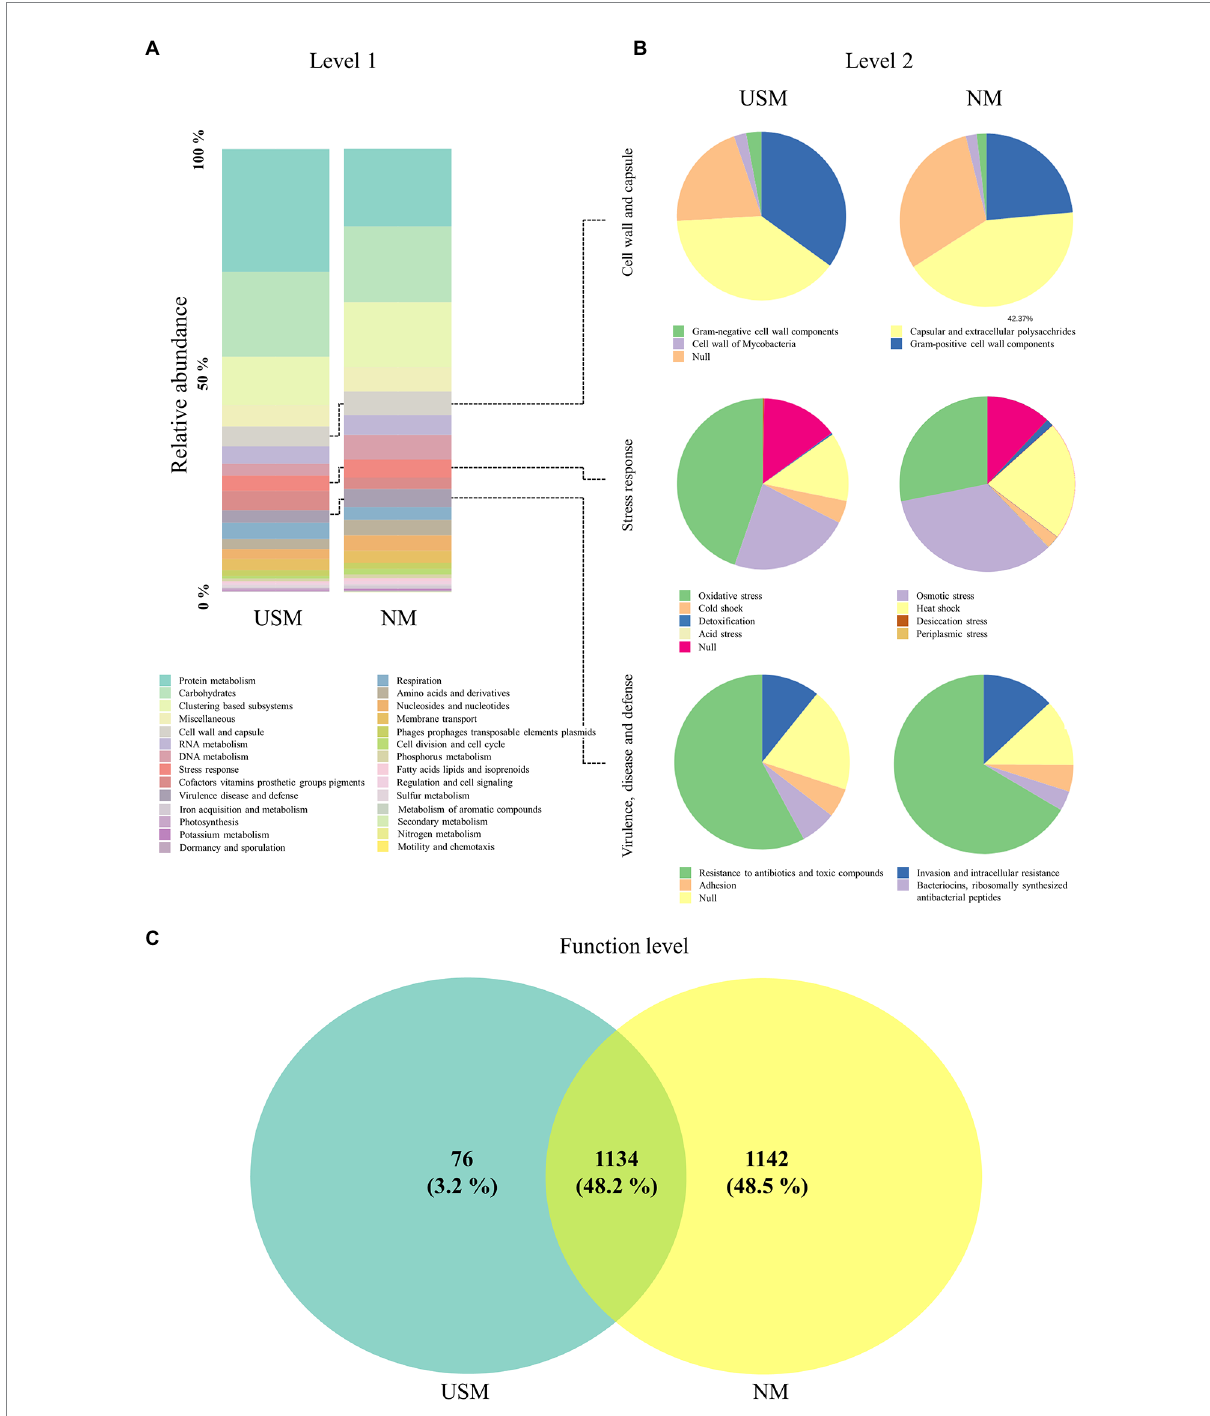
FIGURE 2 Relative abundance profiling of metatranscriptome analyzed in the USM and NM. The relative abundance profiling of transcripts was analyzed in level 1 (A) , and the relative abundance profiling of sub transcripts related to “cell wall and capsule,” “stress response,” and “virulence, disease, and defense” was analyzed in level 2 (B) . A Venn diagram confirmed the relationship between samples on the functional level (C)